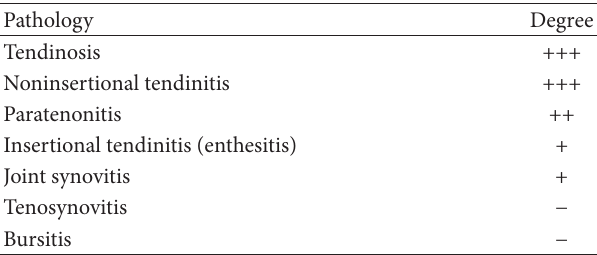
Table 1: The degree of ultrasound pathologies at the onset of rheumatoid arthritis in the present